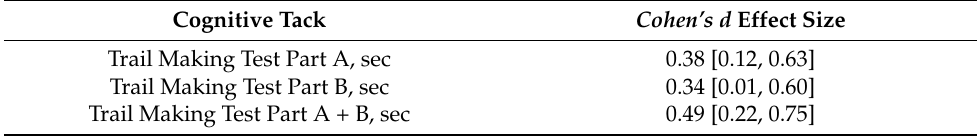
Table 2. Effect sizes for comparisons of time to complete cognitive task (pre vs. post-exercise). Cognitive Tack Cohen’s d Effect Size Trail Making Test Part A,